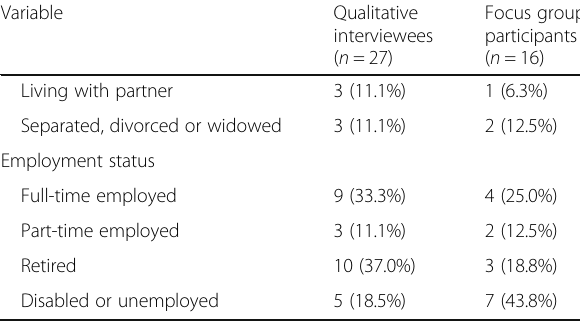
Table 1 Characteristics of study participants